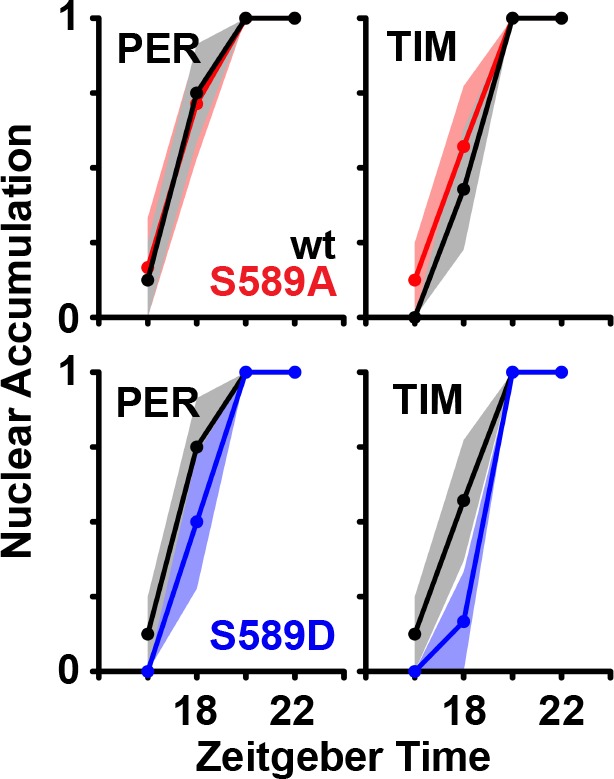
Residue substitutions of S589 do not affect nuclear accumulation in the large ventral lateral neurons in vivo.Stained fly brains were visually scored to determine PER/TIM nuclear accumulation. PER or TIM staining that is predominantly nuclear or cytoplasmic in the small LNvs were valued 1 or 0, respectively. Six to ten fly brains were averaged for each mutant (S589A, red line; S589D, blue line) at the indicated time points, and compared to wild type (black line). Times are measured in ZT. Each data point represents the mean, ±SEM. Thickness of the curve reflects SEM.